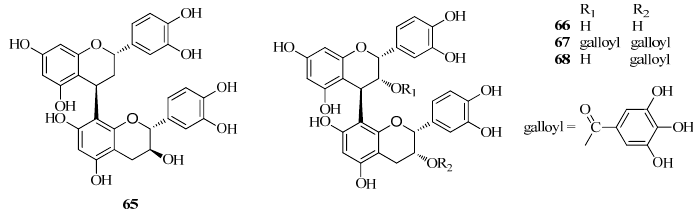
Figure 1. Structures of flavonoids isolated from Fagopyrum esculentum ( F. esculentum ), Fagopyrum tataricum ( F. tataricum ) and Fagopyrum dibotrys ( F. dibotrys ).